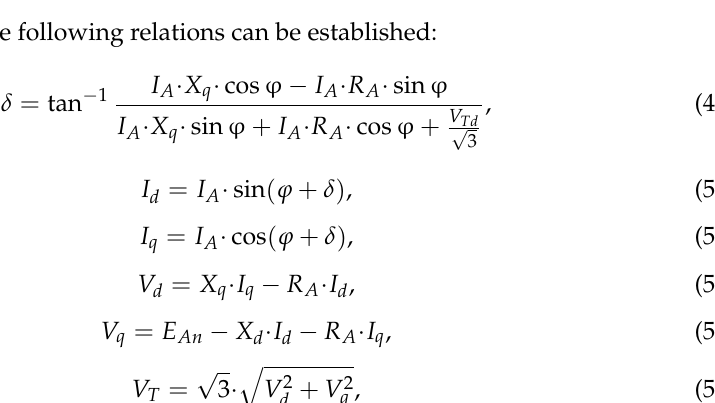
Figure 6. Generator phasor diagram.